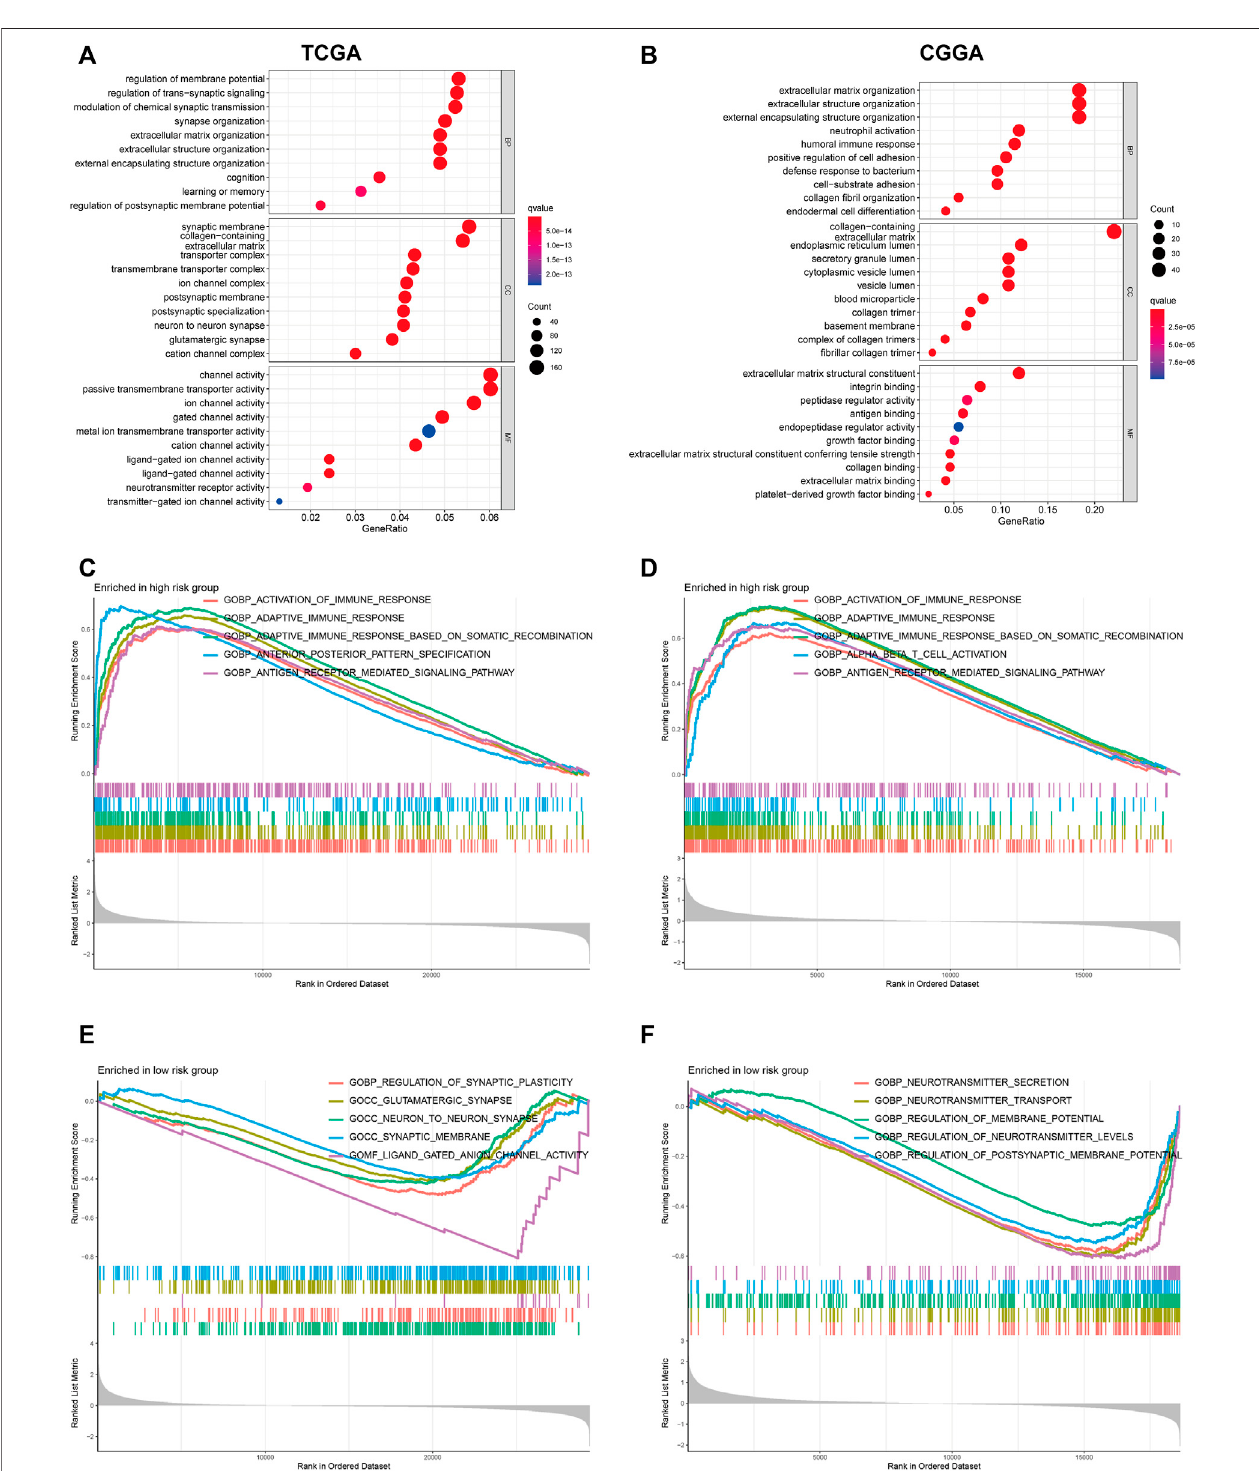
FIGURE7| GOfunctional enrichment analyses betweendifferentPRGsriskgroups. (A,B) Bubble graphofGOenrichment analysisbetweenhigh- andlow- PRGs riskgroupusingTCGA (A) andCGGA (B) . (C – F) GSEAGOanalysesofdifferentPRGsriskgroupinTCGAorCGGAdatasets. (C) :highrisk,TCGA; (D) :highrisk,CGGA; (E) : low risk, TCGA; (F) : low risk, CGGA). GO, Gene Ontology. PRGs, Pyroptosis Related genes. TCGA, The Cancer Genome Atlas. CGGA, Chinese Glioma Genome Atlas. GSEA, gene set enrichment analysis.